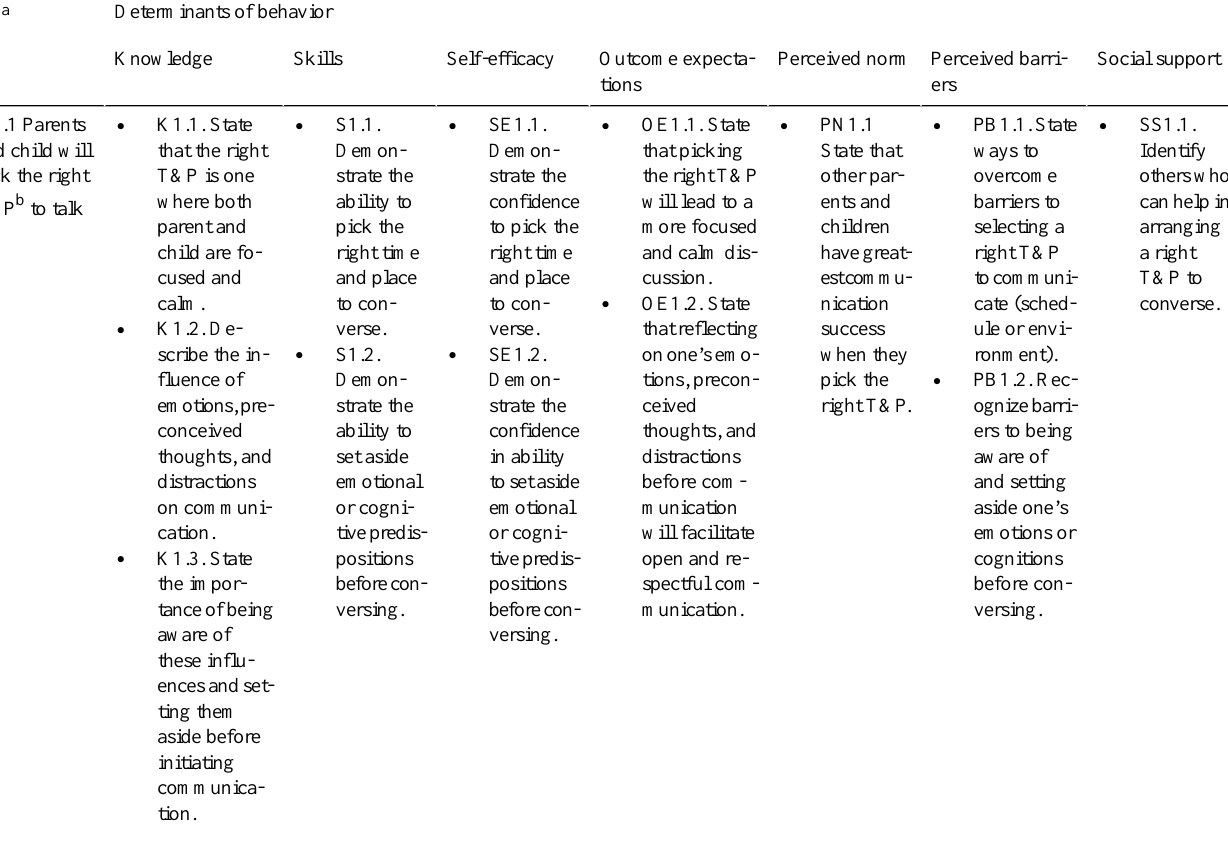
Table 3. Parent matrix for the dyadic parent-youth communication outcome objective that parents and children will interact in a mutually engaging and responsive communication process to achieve shared